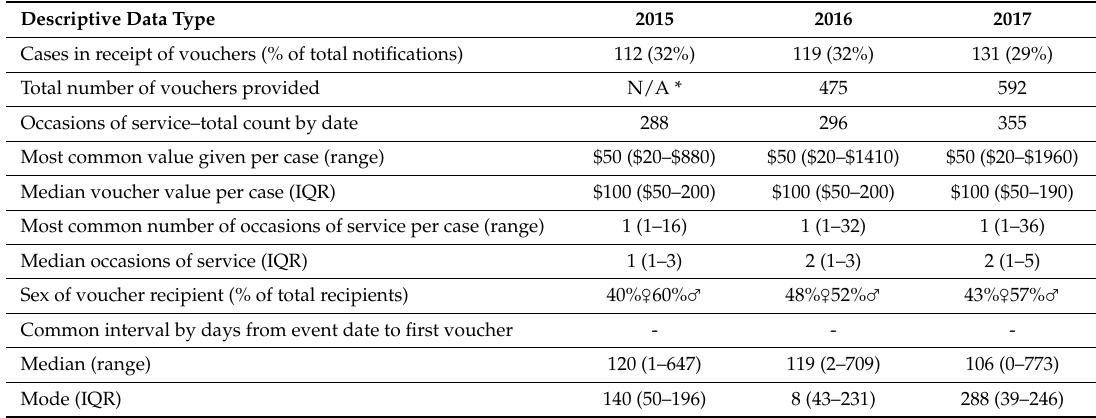
Table 1. Voucher Dissemination Summary by Year,